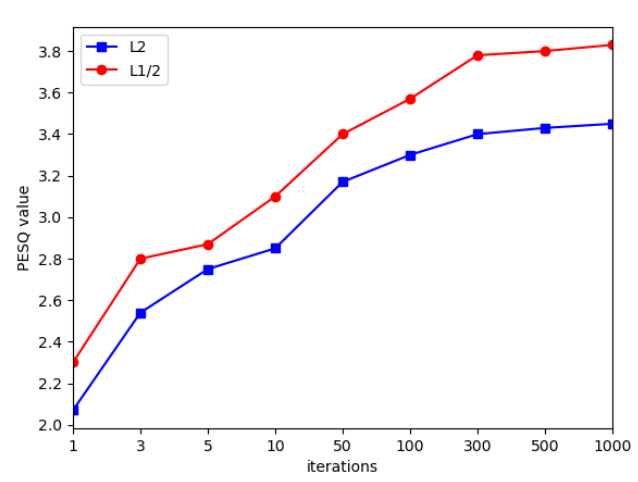
Figure 2. Experimental comparison of the L2 and L1/2 methods with different iteration numbers in speech inversion.